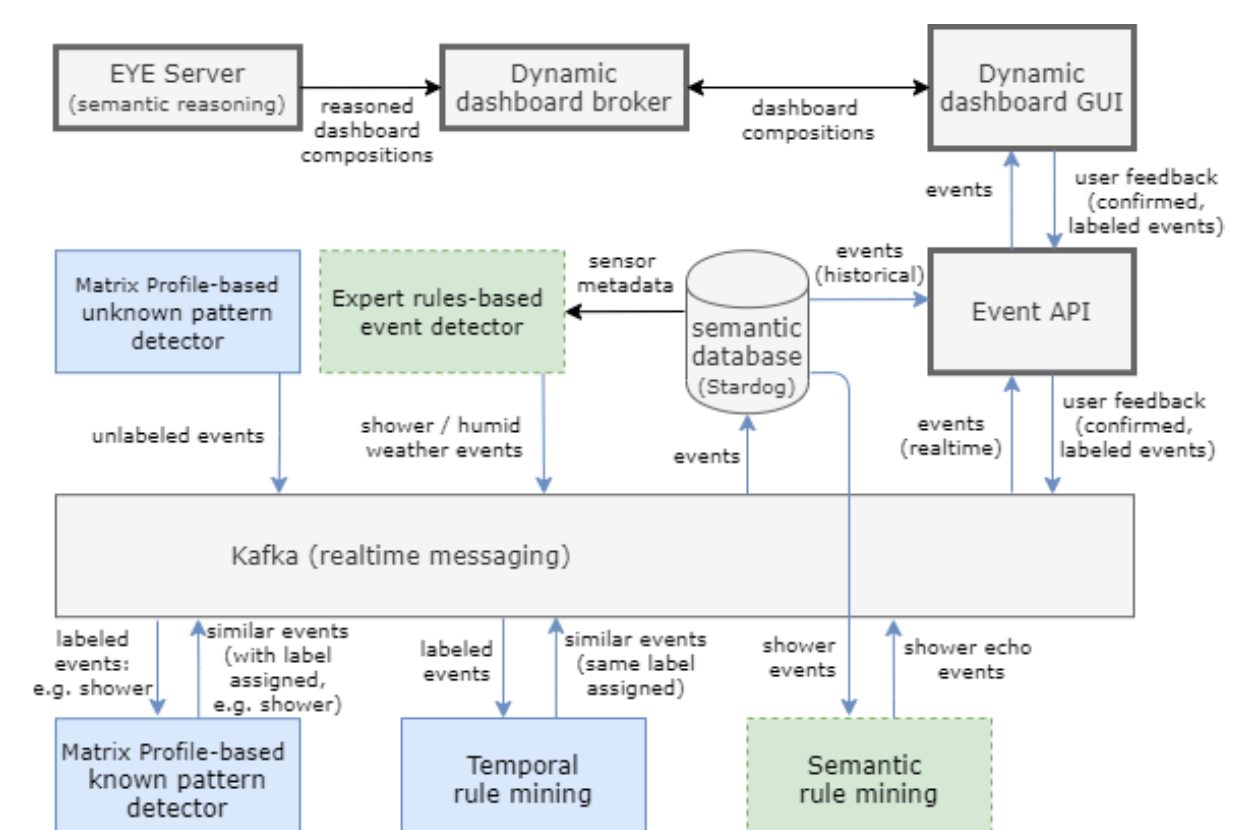
Figure 4. Overview of the interplay of event detectors (colored, thin border) and the dashboarding platform (grey, thick border). Data-driven detectors are displayed in blue (solid border), knowledge-driven in green (dashed border). Arrows indicate the flow direction of